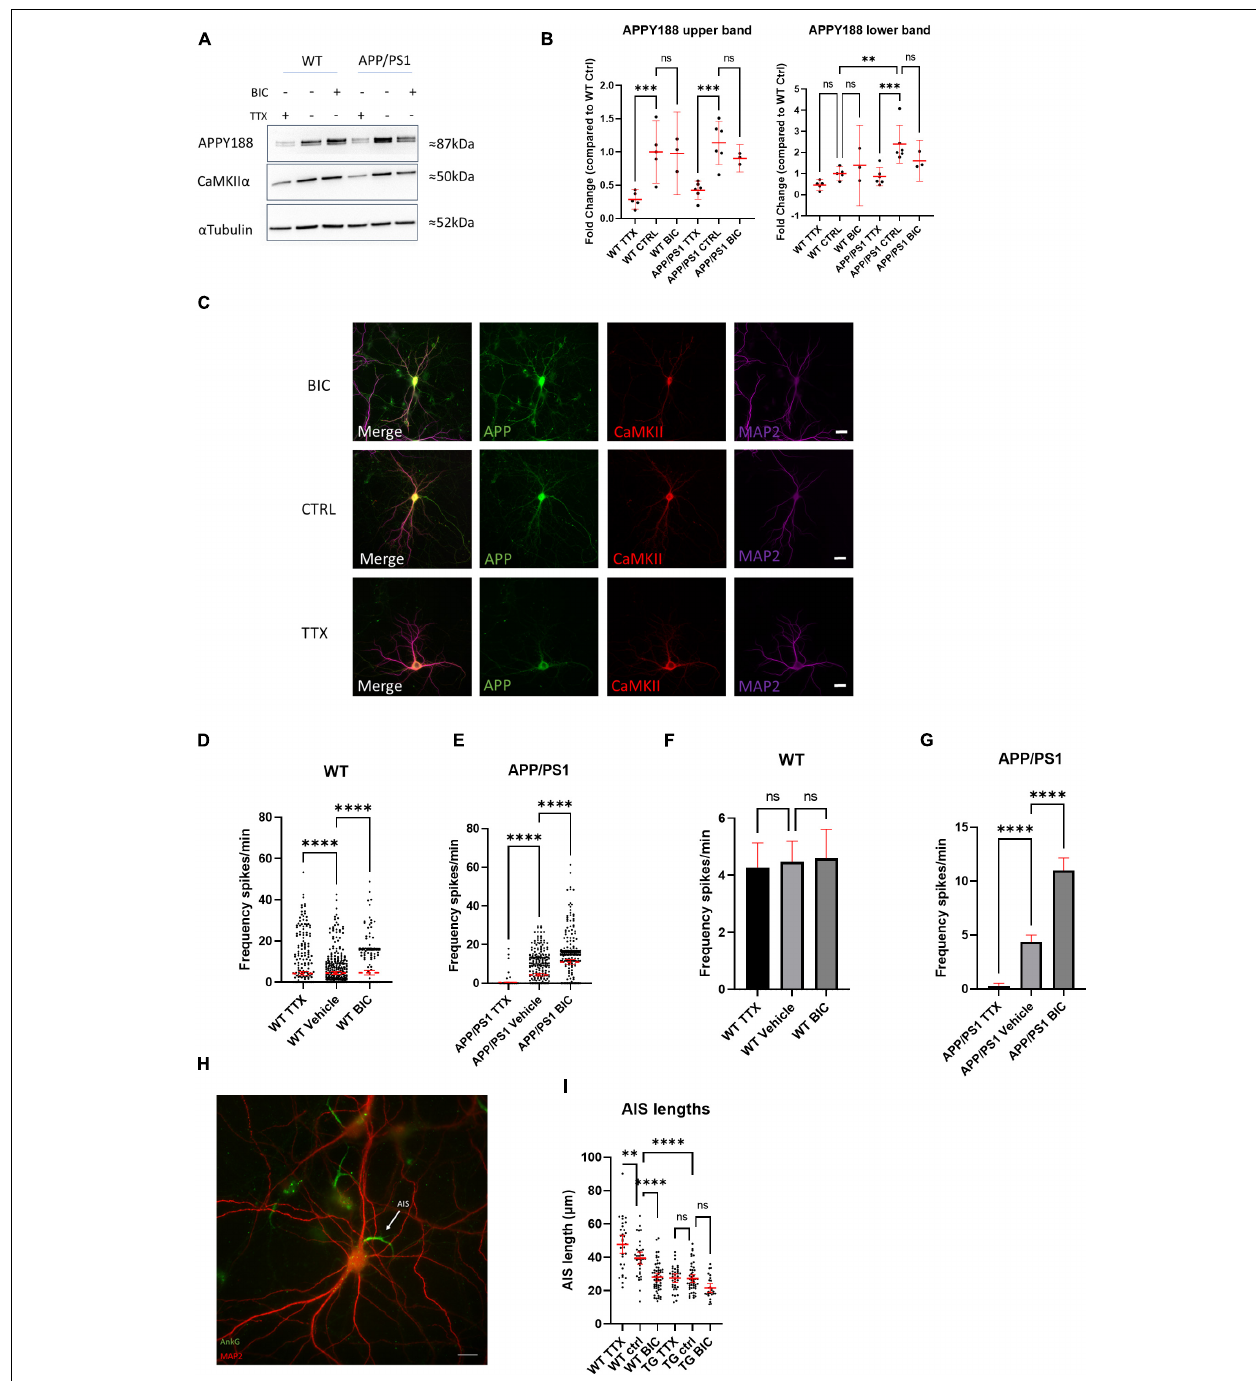
FIGURE 6 | Neurons from AD transgenic mice are unable to initiate homeostatic synaptic/intrinsic plasticity. (A) Representative western blot of APP (using antibody APPY188) and CaMKII α in WT and APP/PS1 neurons treated with TTX or bicuculline for 48 h; α Tubulin is used as a loading control. (B) Graph depicts quantification of fold change from western blots in (A) , APP upper band (WT TTX mean = 0.2865, CI 0.1287–0.4244, n = 5, WT control mean = 1.000, CI 0.5298–1.470, n = 5, WT bicuculline mean = 0.9782, CI 0.3574–1.599, n = 3, APP/PS1 TTX mean = 0.4251, CI 0.2893–0.5609, n = 6, APP/PS1 control mean = 1.137, CI 0.8116–1.462, n = 6, APP/PS1 bicuculline mean = 0.9038, CI 0.6975–1.110, n = 3) and the fainter APP lower band (WT TTX mean = 0.4605, CI 0.1990–0.7220, n = 5, WT control mean = 1.000, CI 0.6601–1.340, n = 5, WT bicuculline mean = 1.386, CI –0.5278–3.299, n = 3, APP/PS1 TTX mean = 0.8590, CI 0.4258–1.292, n = 6, APP/PS1 control mean = 2.239, CI 1.493–3.290, n = 6, APP/PS1 bicuculline mean = 1.602, CI 0.6279–2.576, n = 3). Note that the upper APP band is lower in TTX treated WT compared to WT control ( p = 0.0006) and TTX treated APP/PS1 compared to APP/PS1 control ( p = 0.0002). For the APP lower band, it was significantly higher in the APP/PS1 control than the WT control ( p = 0.0017), while APP was lower in the APP/PS1 TTX than the APP/PS1 control ( p = 0.0003; one-way ANOVA, Šidak